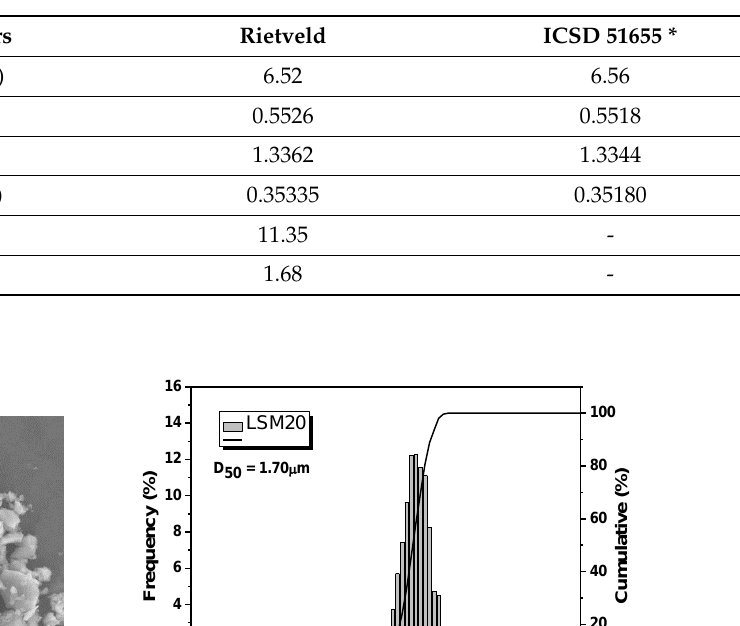
Figure 6. XRD patterns of the composites analyzed.